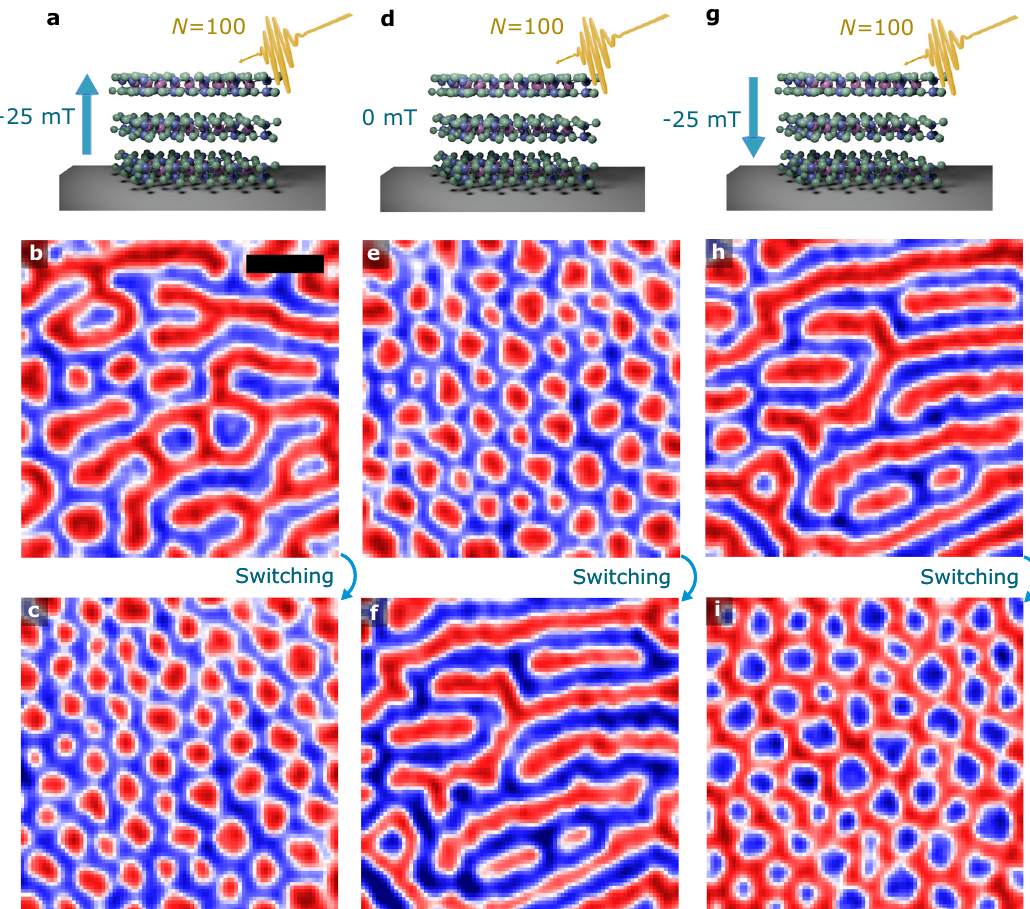
Fig. 3 | Light-induced spin toggle switch. a Schematic of CrGeTe 3 crystal under laserexcitations ( N =100 pulses)and anout-of-plane magnetic fi eld(+25mT). b – c , Spin toggle switching observed between two magnetic con fi gurations dominated by stripe domains ( b ) and bubbles/skyrmions ( c ) via WFKM measurements. A magnetic fi eld of +25mT and N =100 laser pulses are applied to induce the transition. d Similar as in a but without any applied fi eld. e – f The magnetic con- fi guration in c isused asareferencestate to anewswitching process in e with zero fi eldand under N =100laserpulses.The fi nalequilibratedstateis shown in f witha